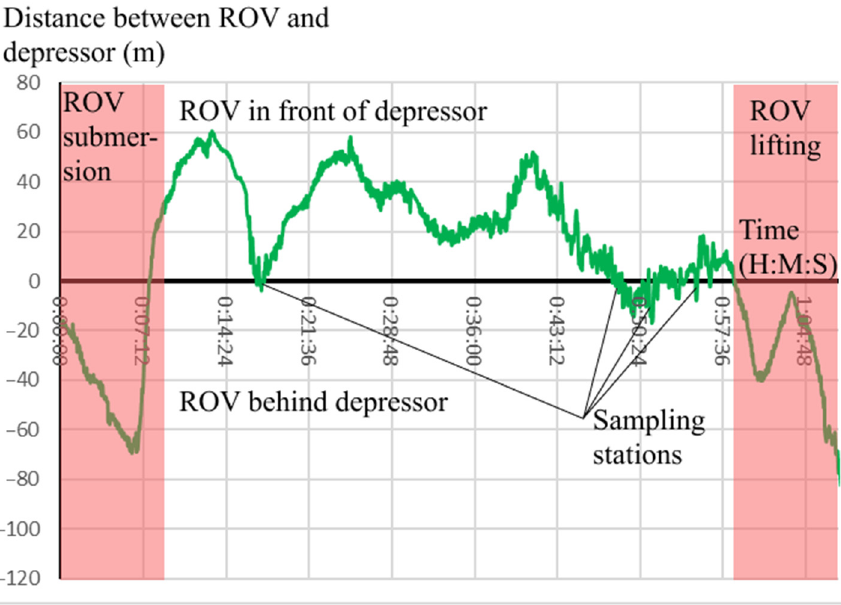
Figure 7. Time histories of movements of the ROV and the depressor.